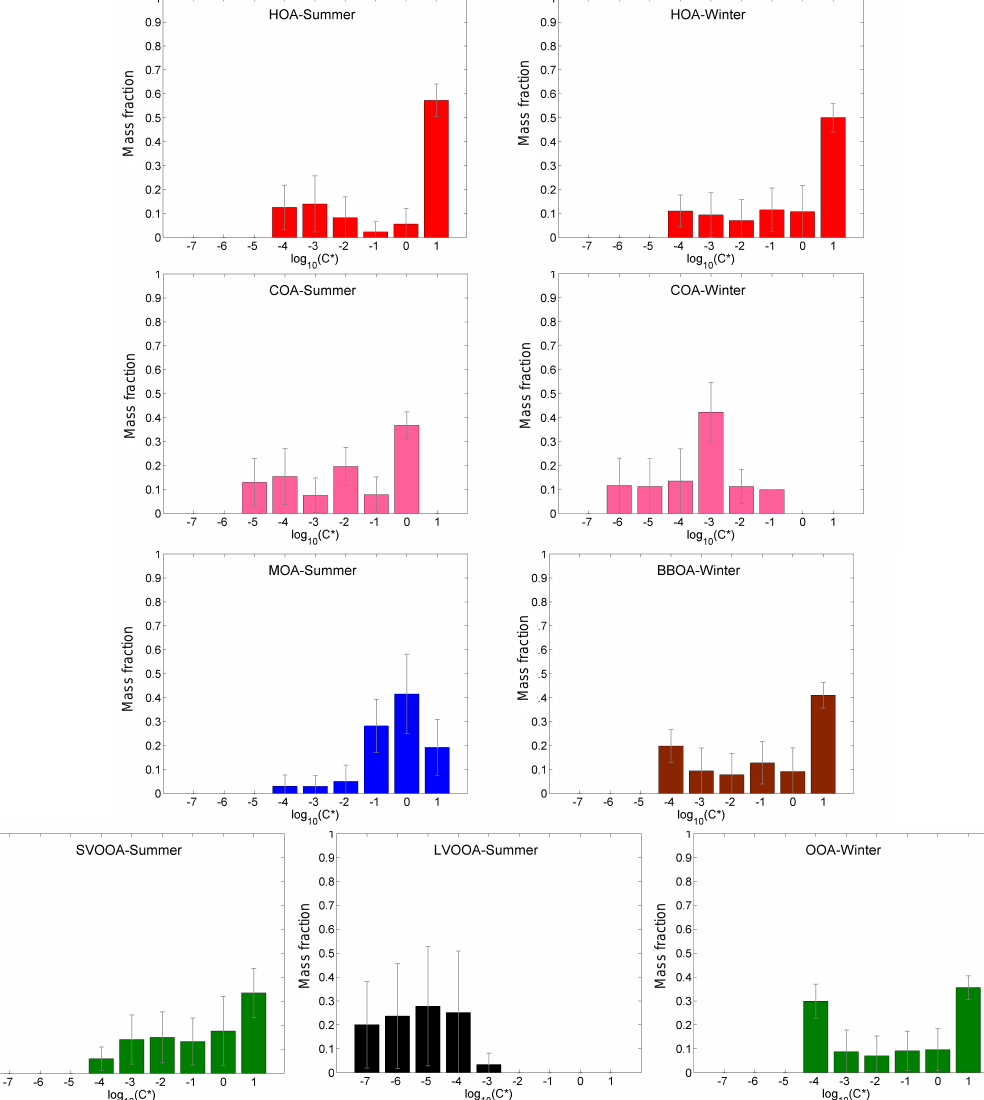
Figure 5. Estimated volatility distributions for summer PMF factors (left panel) and winter PMF factors (right panel). The error bars corre- spond to the fitting uncertainties according to the algorithm of Karnezi et al.